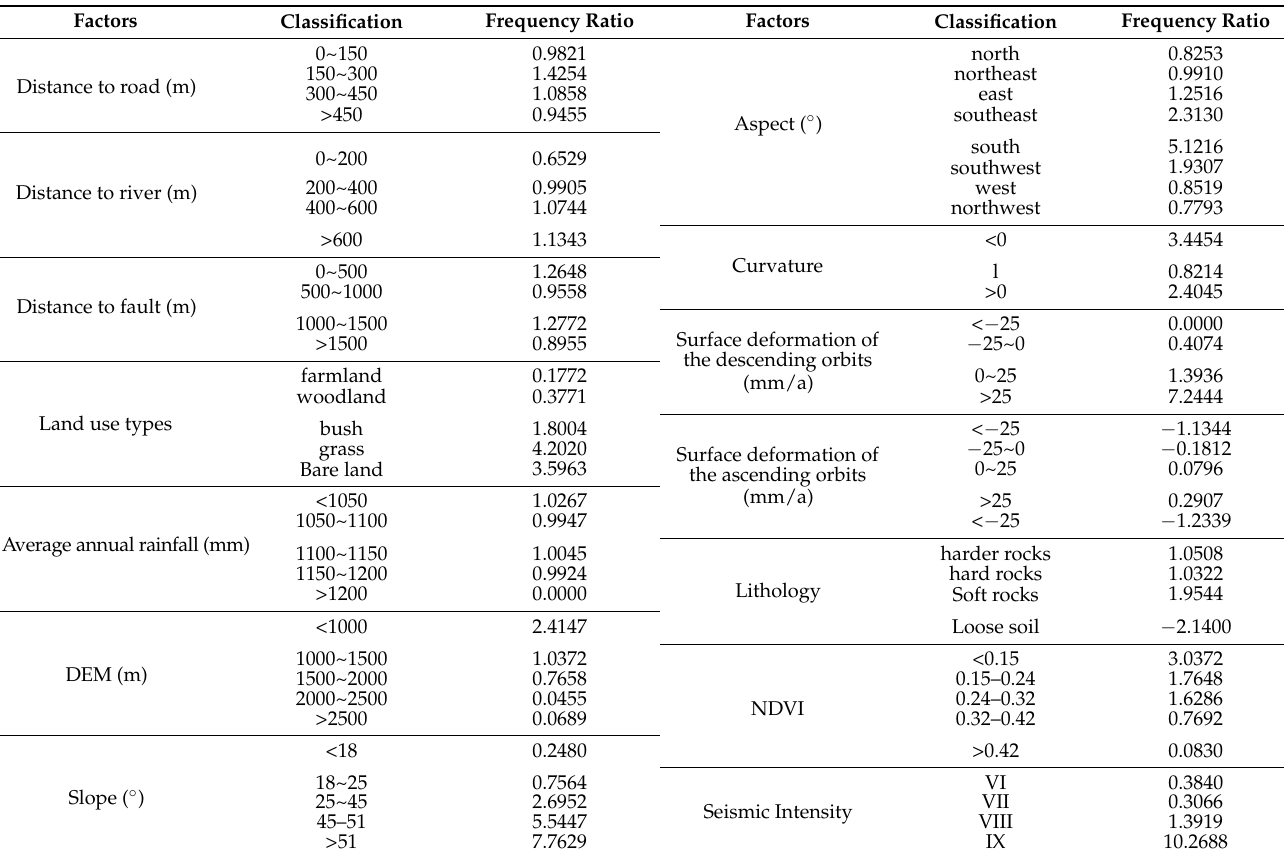
Table 8. Landslide susceptibility evaluation factors grading